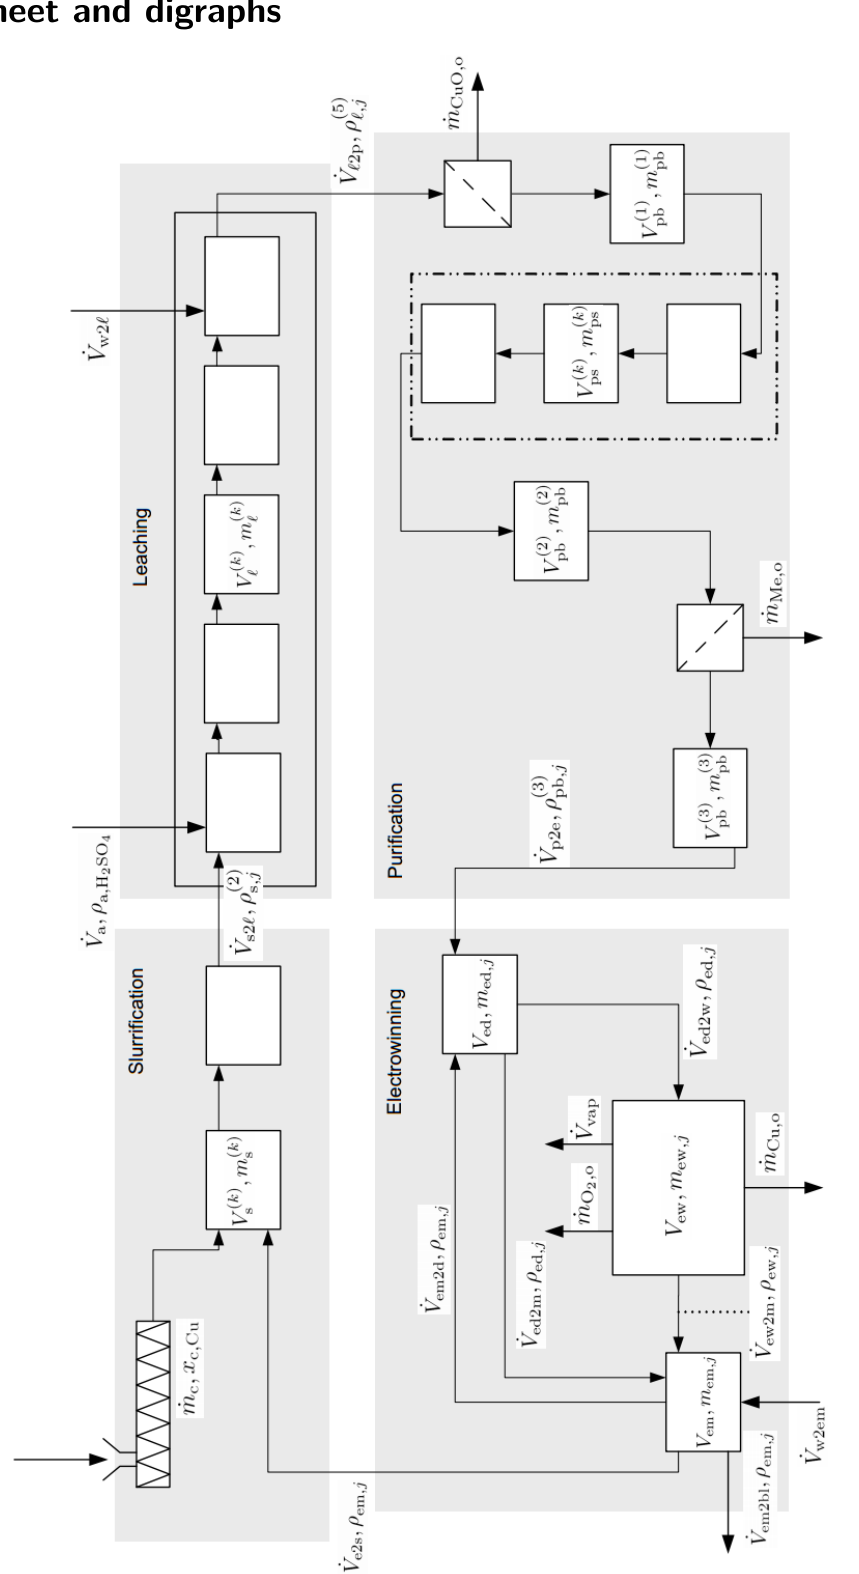
Figure 7: The process flow sheet for the Copper electro-winning